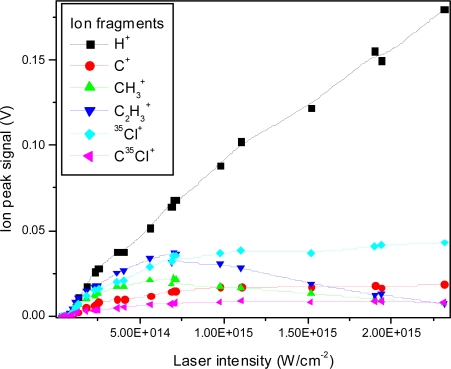
Ion peak signals as a function of laser intensity for H+, C+, CH3+, C2H3+, 35Cl+, C35Cl+ fragment ions using 795 nm laser radiation with 150 fs pulse duration.